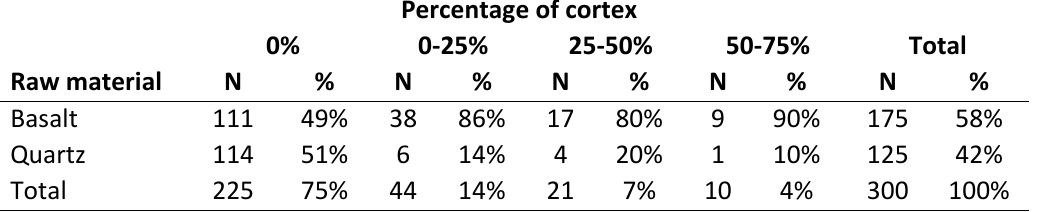
Table 8. Percentage of cortex among flakes from GOT